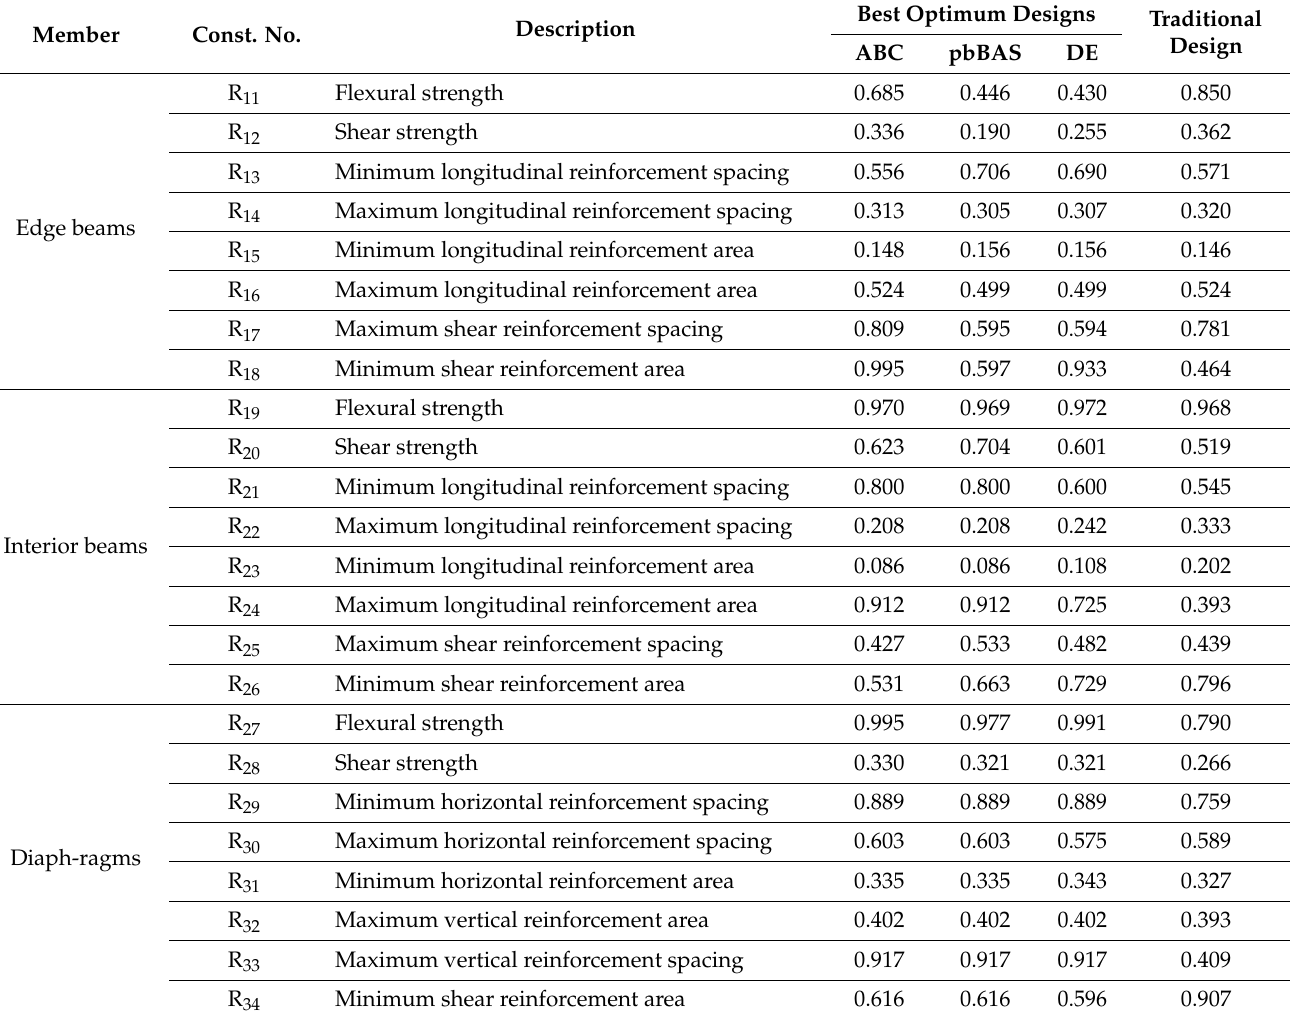
Table 19. Auxiliary members’ constraints the maximum demand capacity ratio in the optimum designs achieved by each metaheuristic algorithm for the V-type folded plate roof building. Member Const. No.